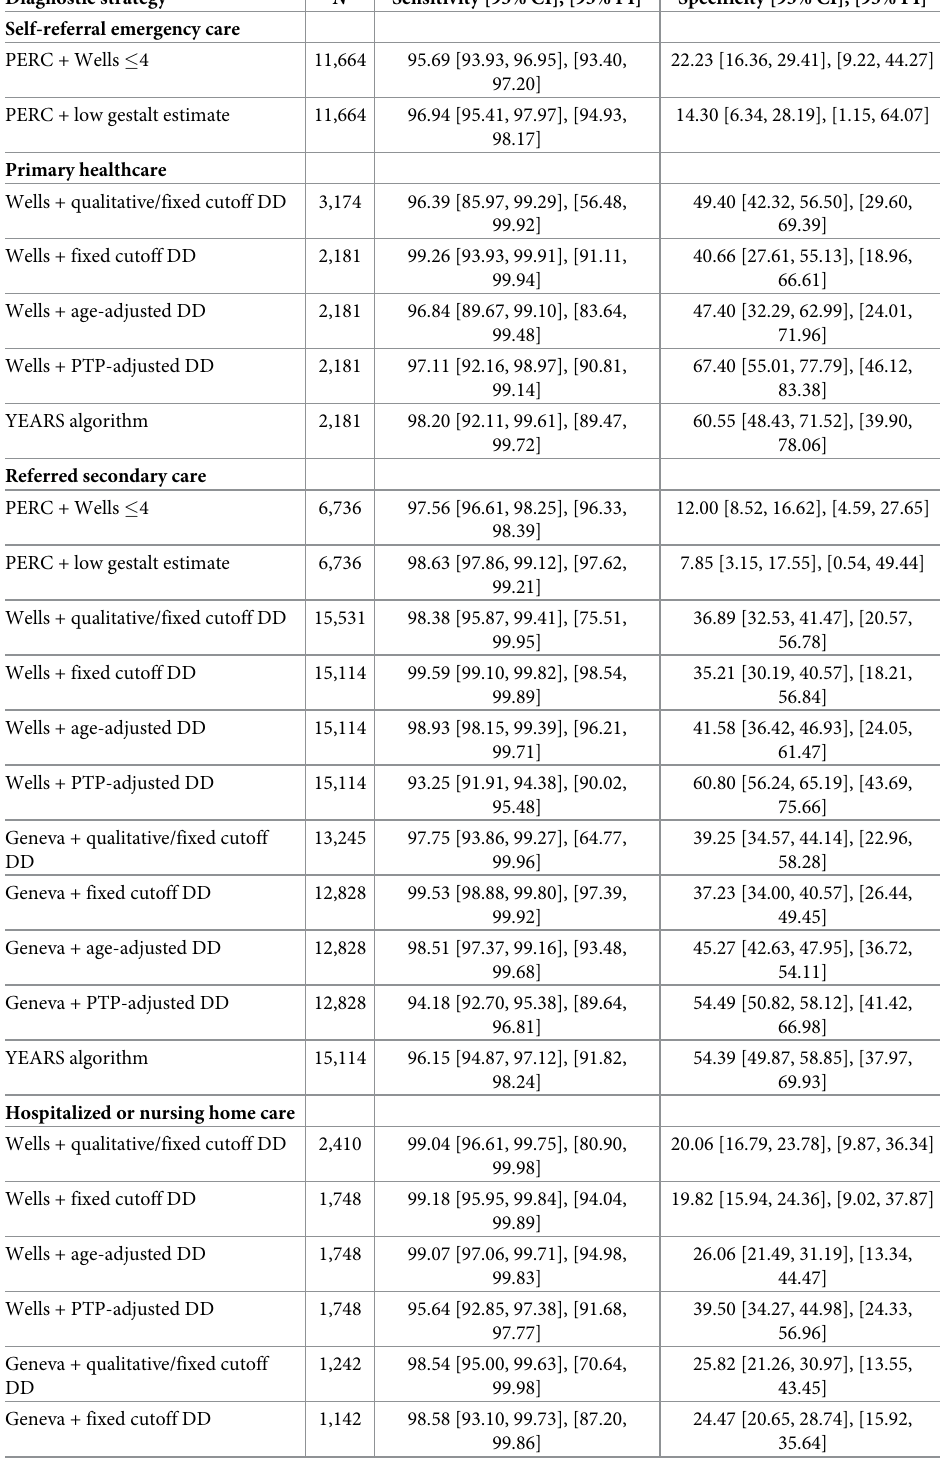
Table 2. Sensitivity and specificity of diagnostic strategies across healthcare